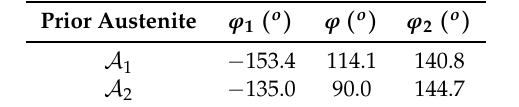
Table 2. The Euler angles corresponding to the prior austenite orientations